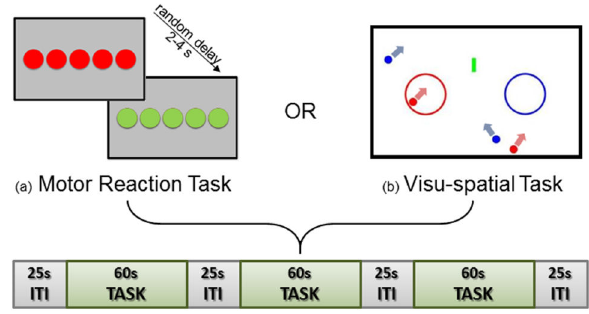
Figure 1. Experimental paradigm. Every run was constituted by three task blocks (each 60 s duration) alternated with two inter-task intervals (ITI, each 25 s duration). During the Motor Reaction task (a), subjects had to press a button as quick as possible when the red light turned green (random delay comprised between 2 and 4 s). During the Visuo-spatial task (b) volunteers were required to press a button when one of the moving balls entered the color-matched